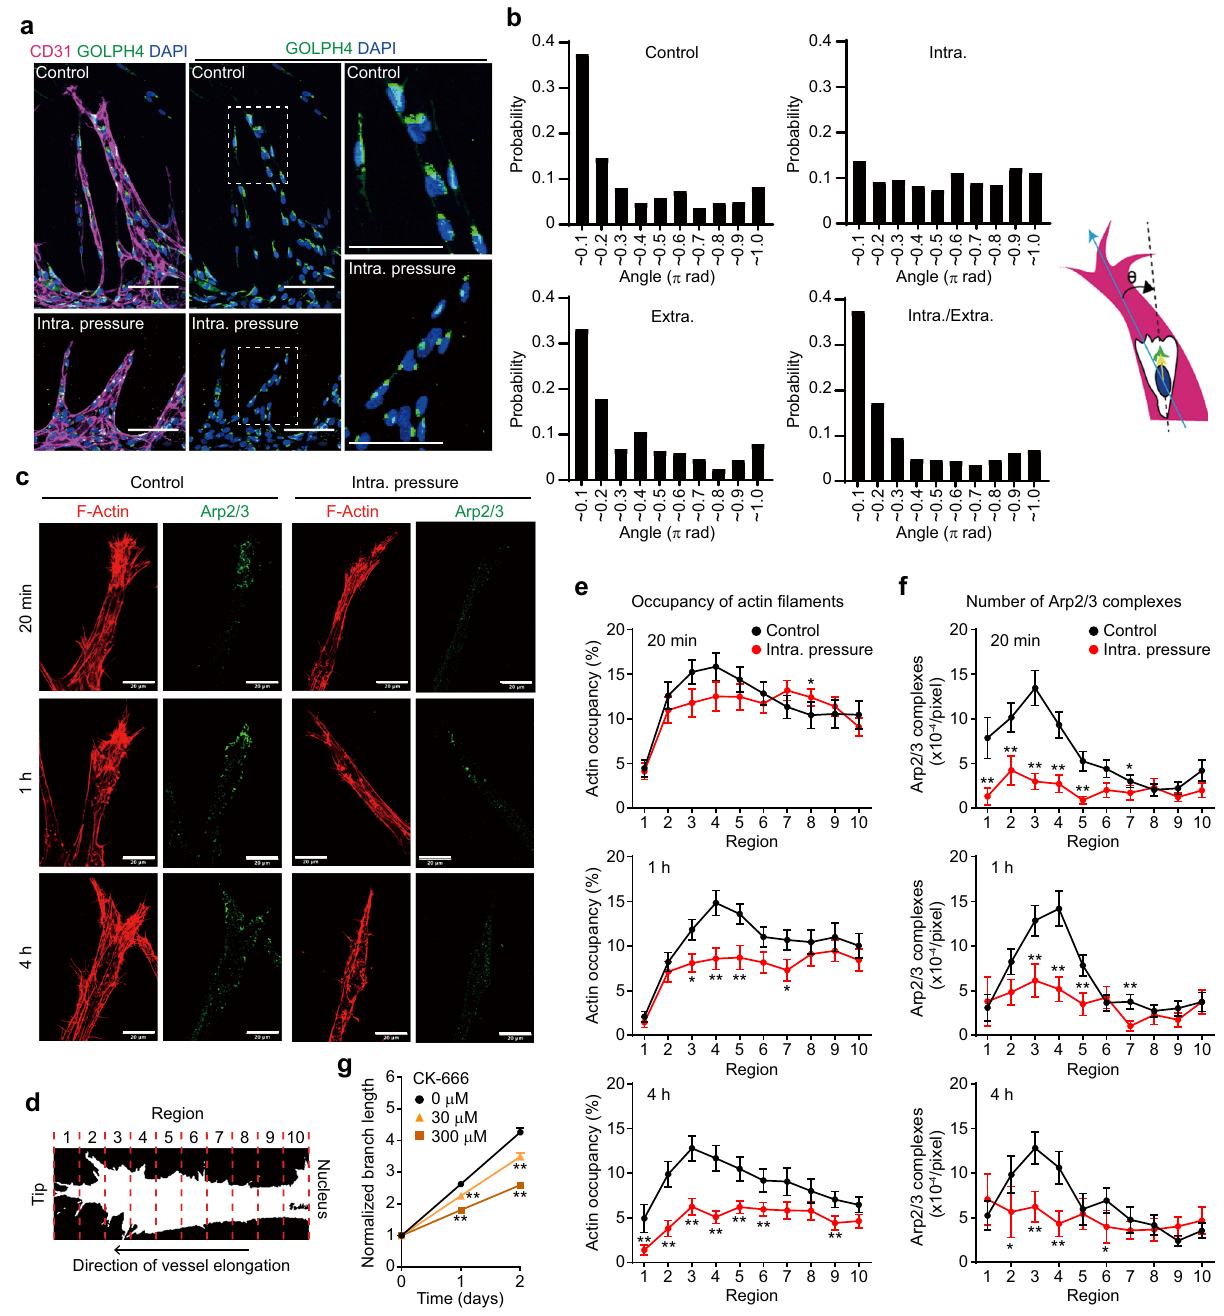
(Fig. 4g and Supplementary Fig. 11). These results suggest that IP load-induced stretching of ECs in angiogenic branches prevents leading edge localization of Arp2/3 complexes, thereby inhibiting actin polymerization and front – rear polarization leading to impaired blood vessel elongation. IP load-induced EC stretching suppresses elongation of upstream injured vessels by inhibiting Arp2/3 complex- mediated actin polymerization and front – rear polarization . Then, we investigated whether IP load-induced EC stretching inhibits Arp2/3 complex-mediated actin polymerization at the leading edge and establishment of front – rear polarity which restricts elongation of upstream injured vessels during wound NATURE COMMUNICATIONS| (2022) 13:2594